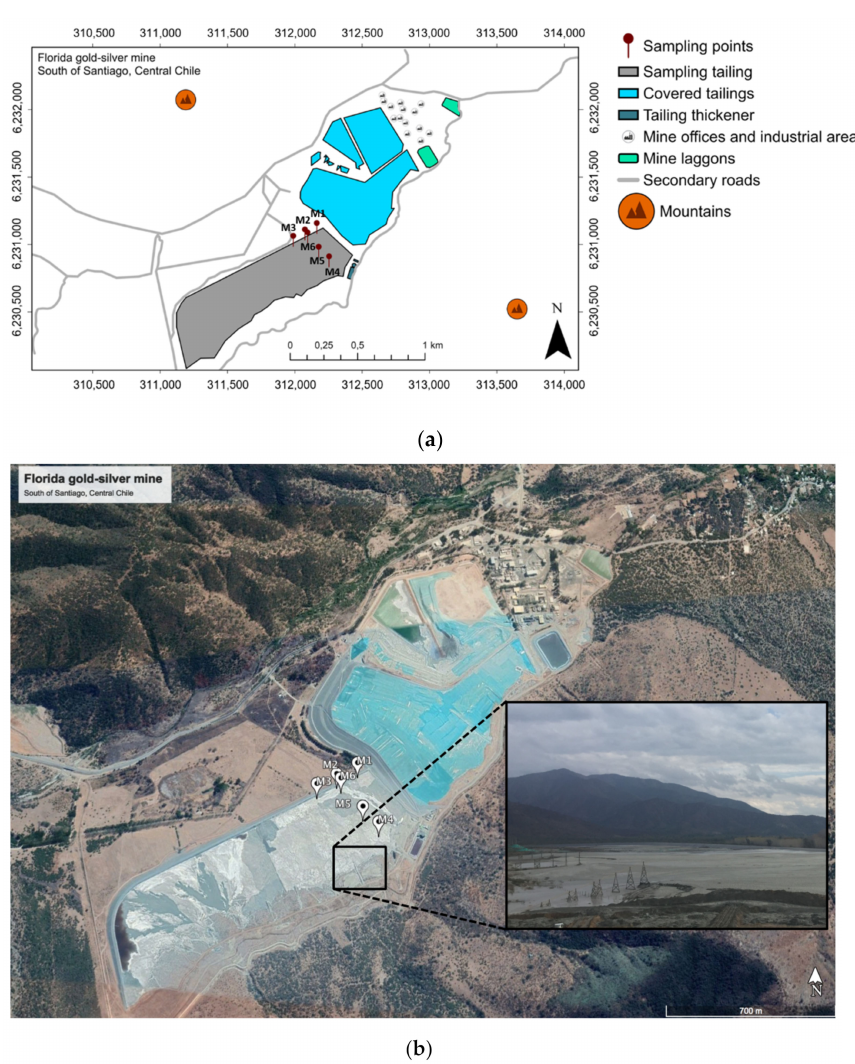
Figure 1. ( a ) Location of tailing sampling points in Florida Gold–Silver Mine, South of Santiago, Central Chile. ( b ) Paste tailings deposit